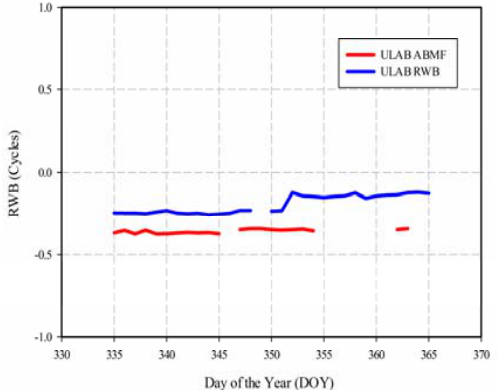
Figure 5. Daily RWB of Both ABMF and ULAB